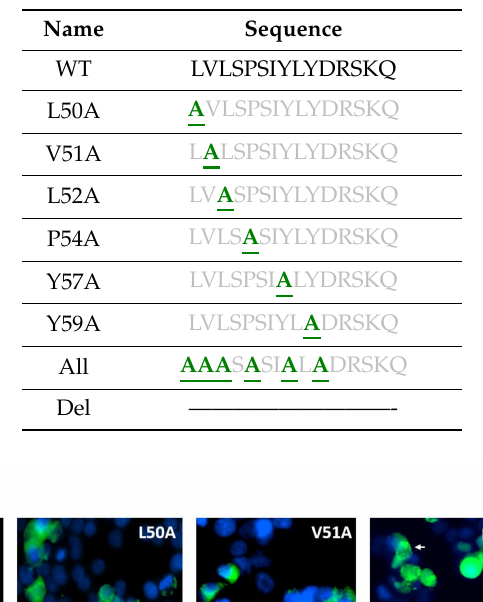
Table 2. Alanine scanning mutations.